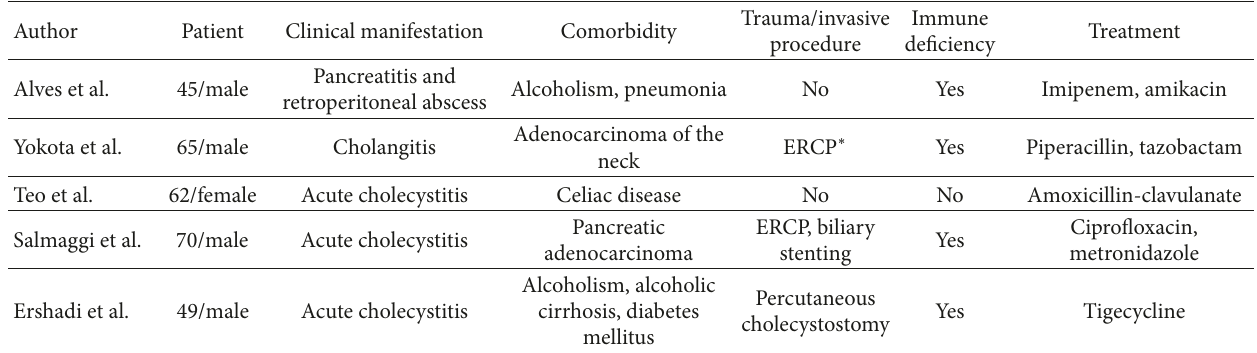
Table 1: Biliary tract related infections caused by R. planticola, reported in the